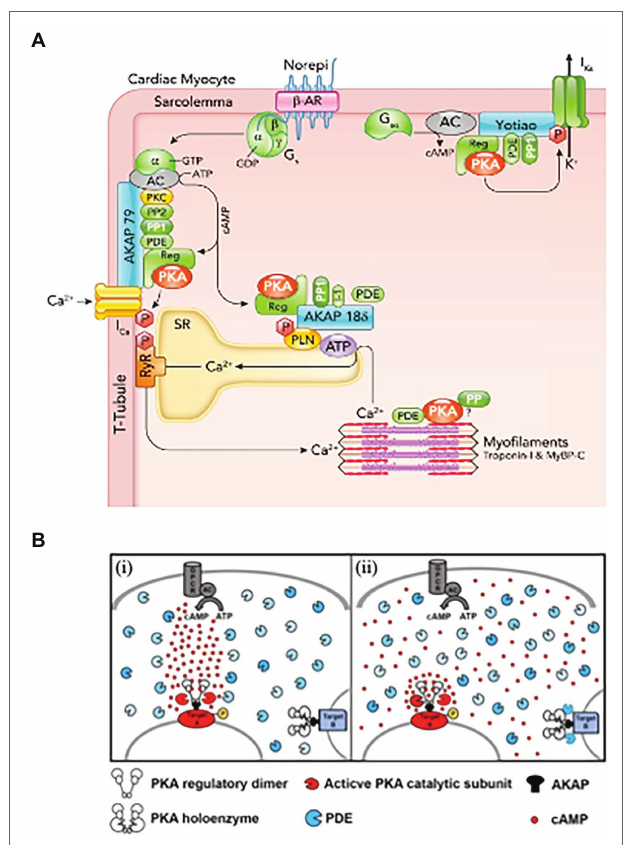
FIGURE 1 | Activation of cardiomyocyte β -adrenoceptors lead to compartmentalized increase in (cAMP). (A) β -AR, cAMP, and PKA signaling proteins in cardiomyocytes. β -AR activated by norepinephrine (Norepi) causes adenylyl cyclase (AC) to produce cAMP, which binds the PKA regulatory subunit. Activated PKA can selectively phosphorylate nearby target proteins including sarcolemmal L-type Ca channels, which increases I Ca , SR phospholamban (PLN), which increases SR Ca-ATPase activity, and KCNQ1 to enhance delayed rectifier K + current I Ks . PKA is anchored at these three targets by specific